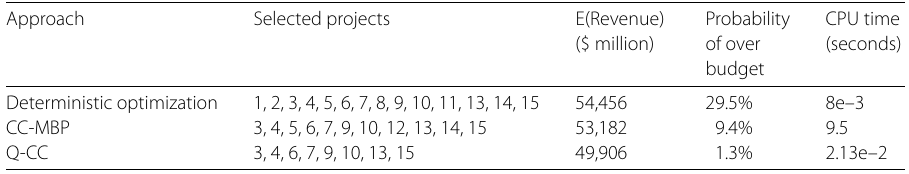
Table 2 Optimal project selection